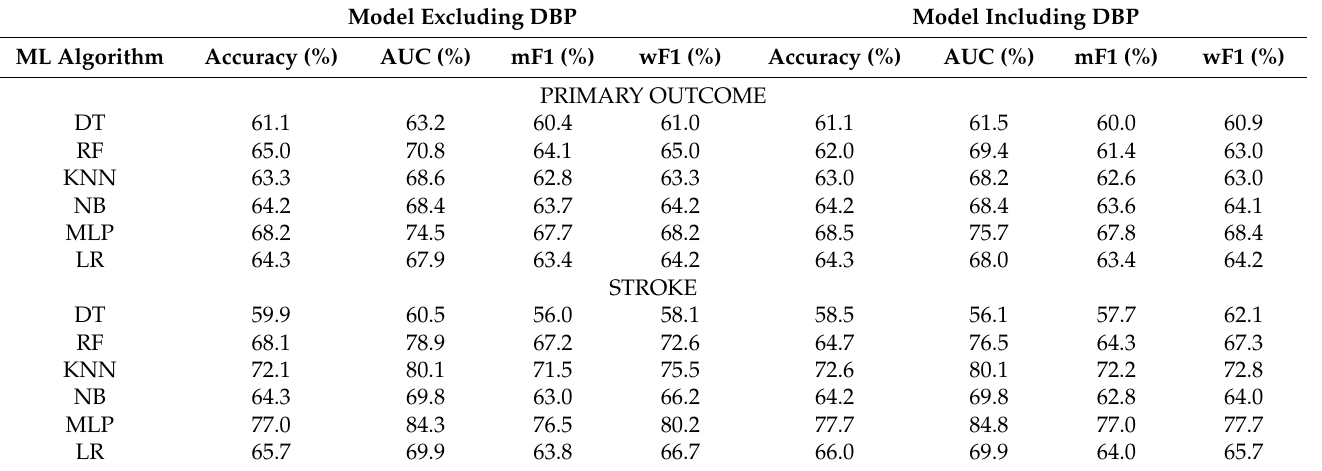
Table 2. Performance of the classifiers for different outcomes, excluding and including diastolic blood pressure in the model for the population with DBP < 70